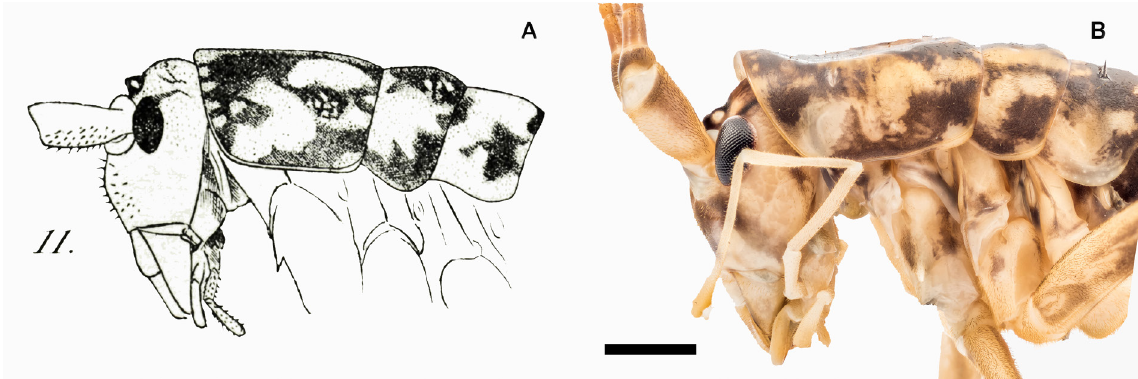
Fig. 13. Pleioplectron thomsoni (Chopard, 1923) comb. nov., adult ♂ A . Original drawing by Lucien Chopard (1923), syntype, ♂, Raincliff Reserve, South Canterbury (MNHN EO-ENSIF4924). B . Pioneer Park, South Canterbury (MPN CW3912). Scale bar = 2